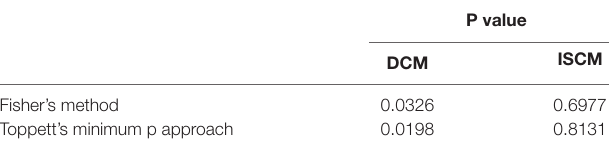
TABLE 5 | Drug analysis enrichment synthesized P